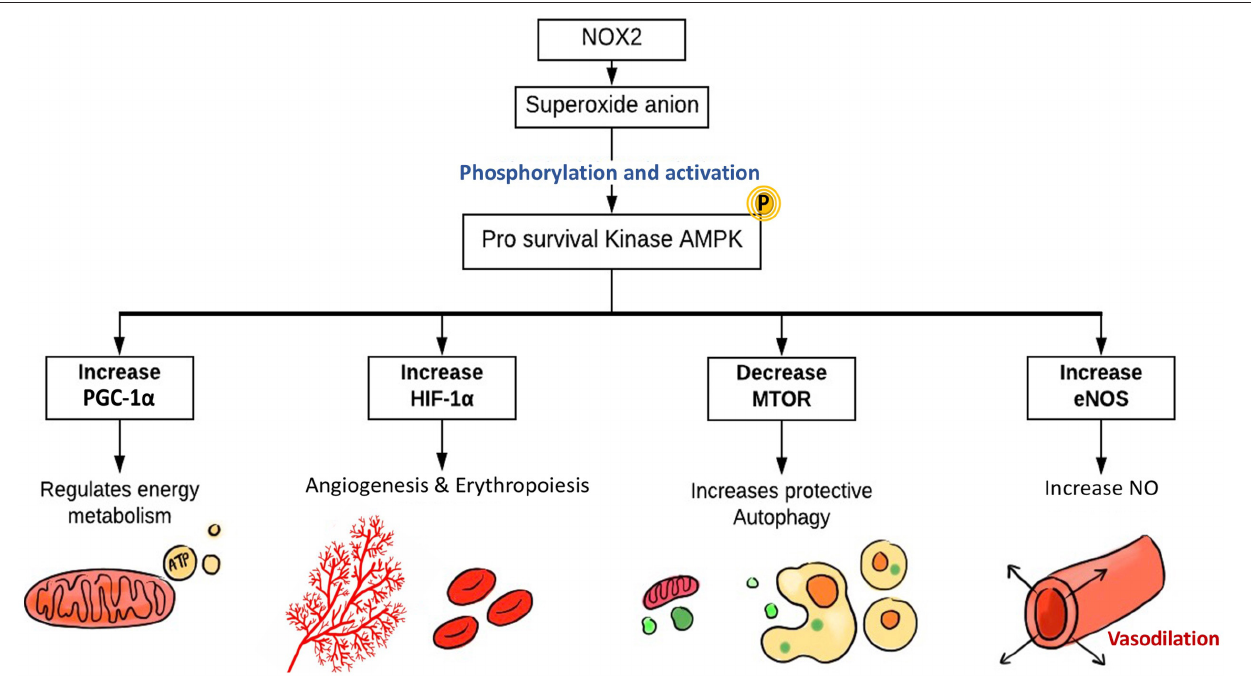
FIGURE 5 | The role of EC-specific Nox2-derived ROS in enhancing ECs function. The main source of ROS in ECs are NOX, particularly NOX2, which generates superoxide. NOX-derived ROS activate AMPK, PGC1- α , and HIF-1 α . The pro-survival kinase AMPK increases eNOS activation and NO synthesis resulting in coronary vasodilatation. HIF-1 α expression induces angiogenesis and erythropoiesis, while PGC1- α regulates mitochondrial biogenesis, energy metabolism, and protective autophagy. NOX, NADPH oxidase; AMPK, AMP kinase; PGC-1 α , PPARG coactivator 1 α ; HIF-1 α , hypoxia-inducible factor 1 α ; mTOR, mammalian target of rapamycin; eNOS, endothelial nitric oxide